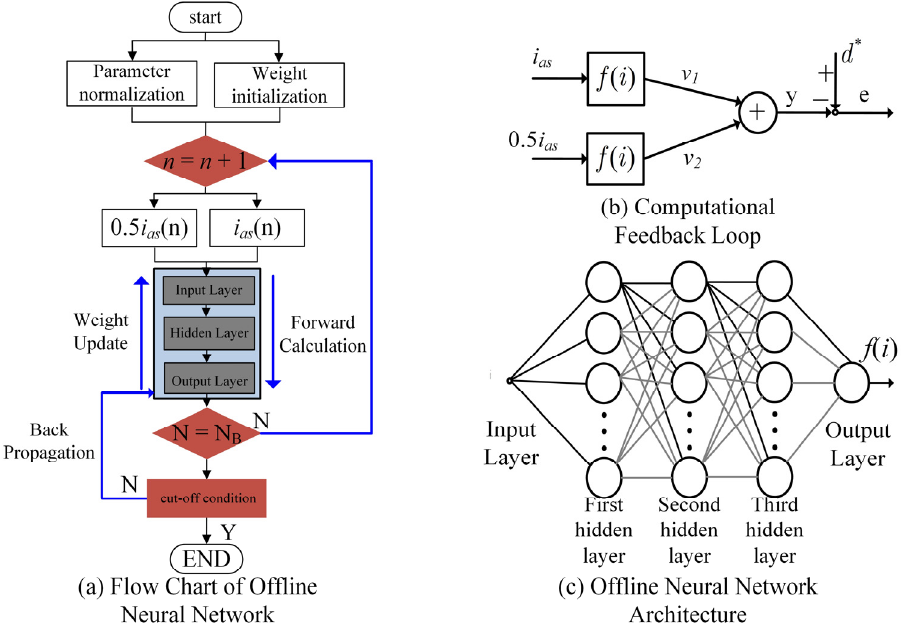
Figure 4. Offline neural network identification process.